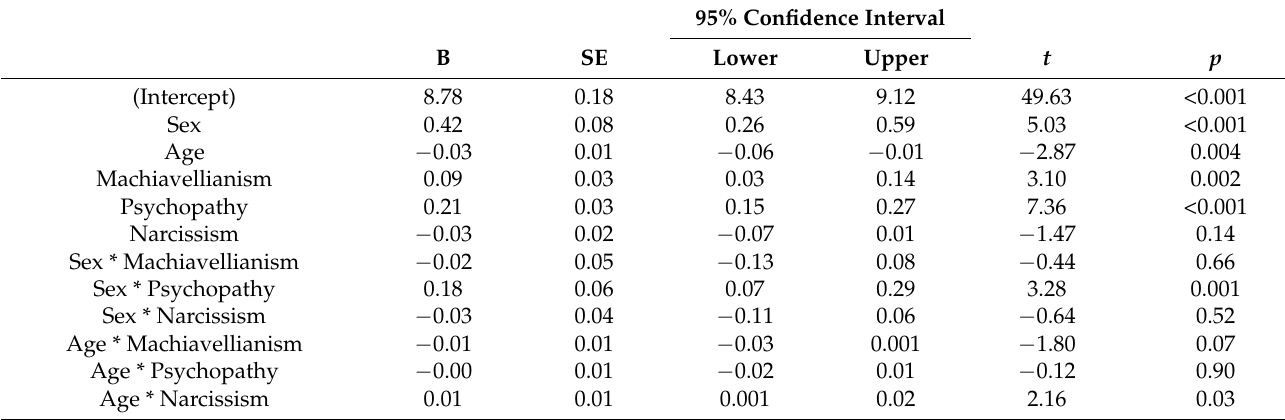
Table 9. Non-consensual sexting: parameter estimates of fixed effects.